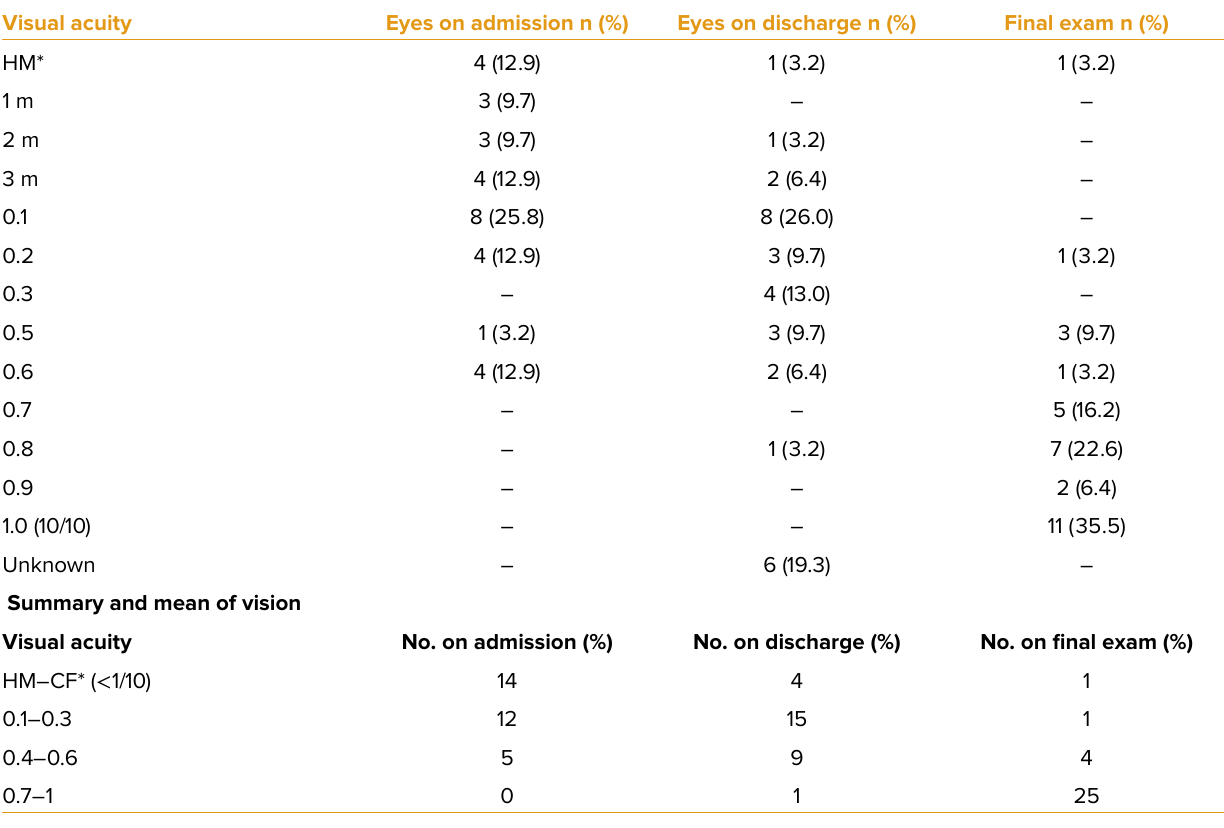
Table 3. Vision on admission, on discharge, and final visual acuity (VA) of the patients who were referred to eye emergency department for adverse drug reactions of tetracaine in southeast of Iran ( N = 31 eyes).